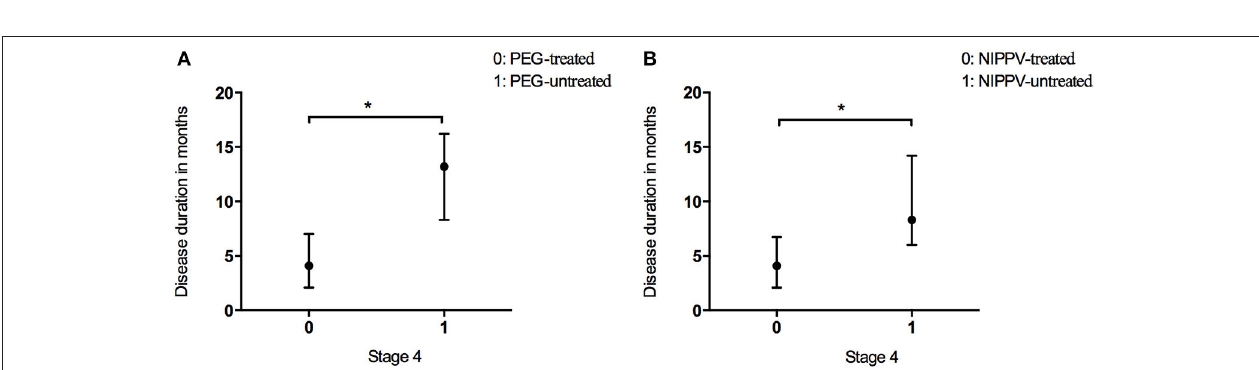
FIGURE 3 | Box plot of duration in months spent at each stage between patients with treatment of riluzole and patient without treatment of riluzole (A) ; between patients with long-term treatment of riluzole and patient with short-term treatment of riluzole (B) ; between patients with early long-term treatment of riluzole and patient with late long-term treatment of riluzole (C) . * P < 0.05.